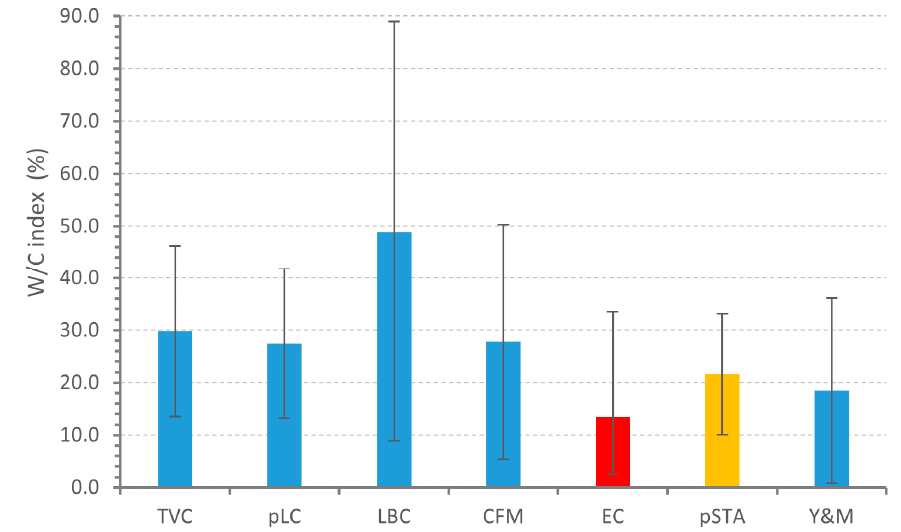
Figure 3. The microbial population partitioning between whey (W) and curd (C). The values of pLC and LBC represent only 3 replications.